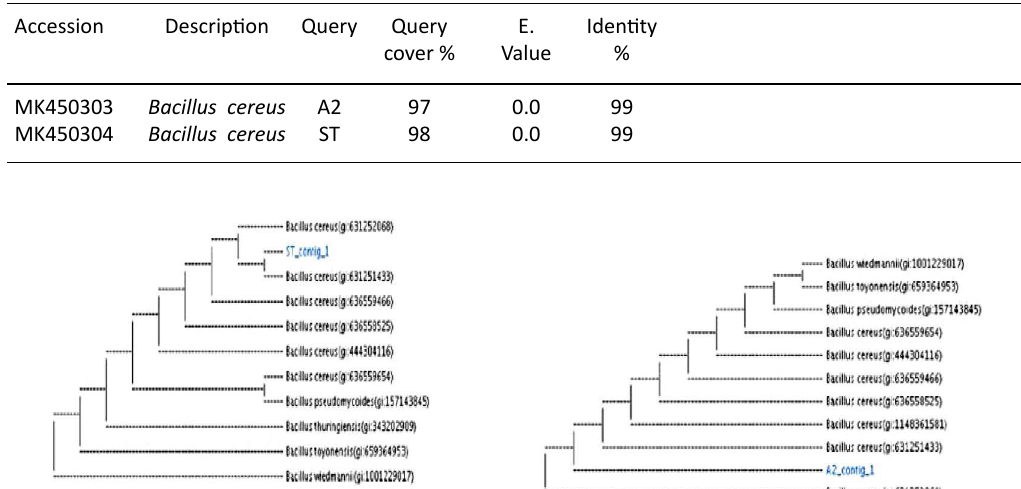
Table 4. The closest identi ed match in the GenBank